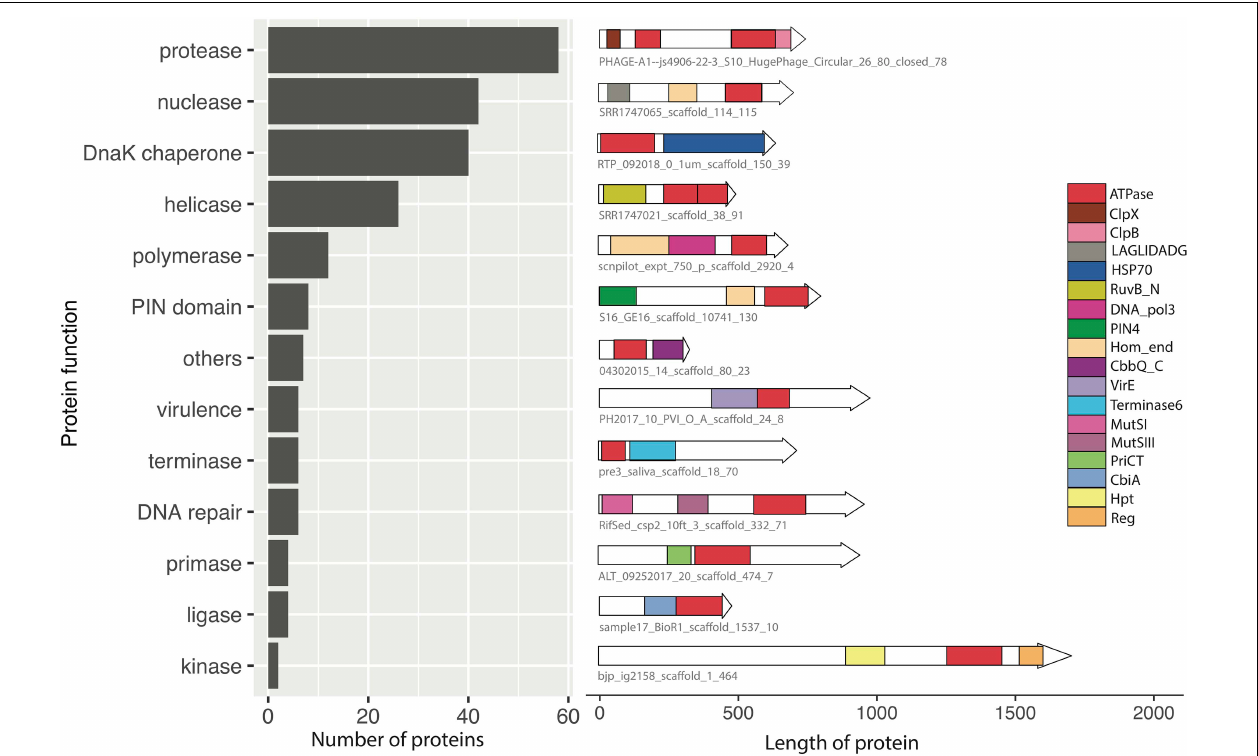
FIGURE 3 | Analysis of the functional domains of composite ATPase proteins from the mobilome metagenomes. The bar chart shows the predicted functions of the 221 composite ATPase proteins are nucleic acid and amino acid interacting enzymes. For each category, a representative example of a composite ATPase protein is shown, with all the known domains drawn to scale. The red rectangles indicate the domains predicted to have energy-utilizing functions such as AAA+ and